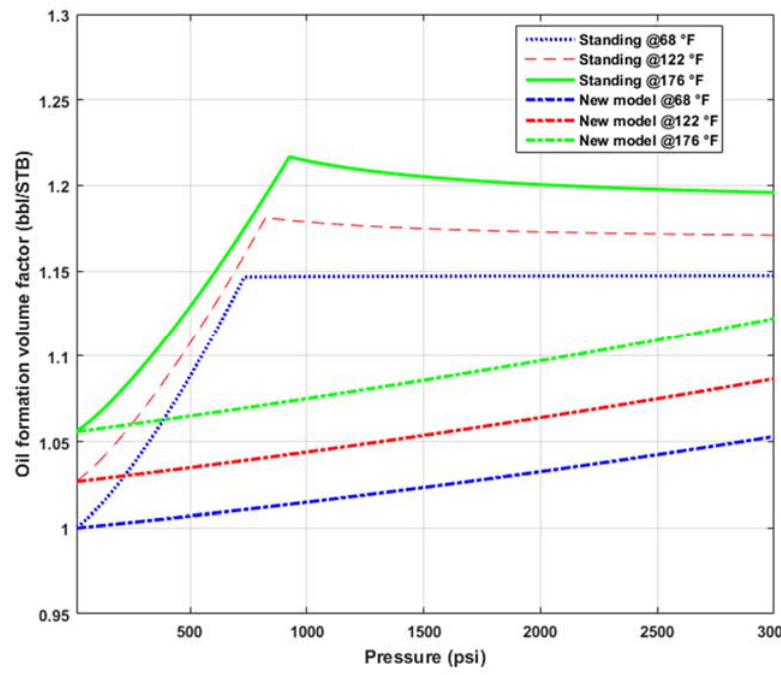
Figure 5. Oil FVF as a function of Standing oil and the new correlations.